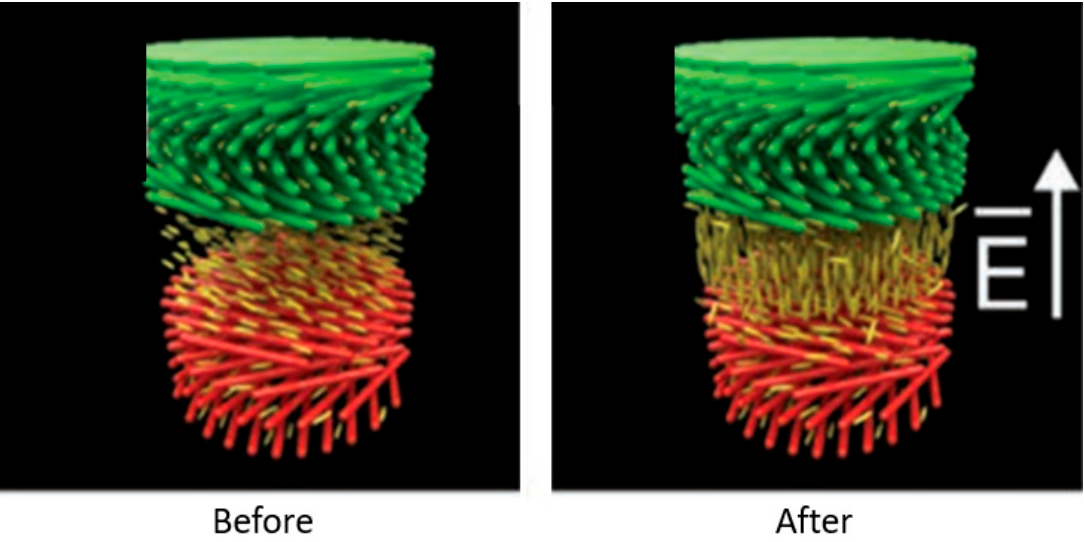
Figure 13. The orientational effect on CNC after an electric field (E) is applied to a 5CB positive dielectric nematic layer. Adapted from [108].